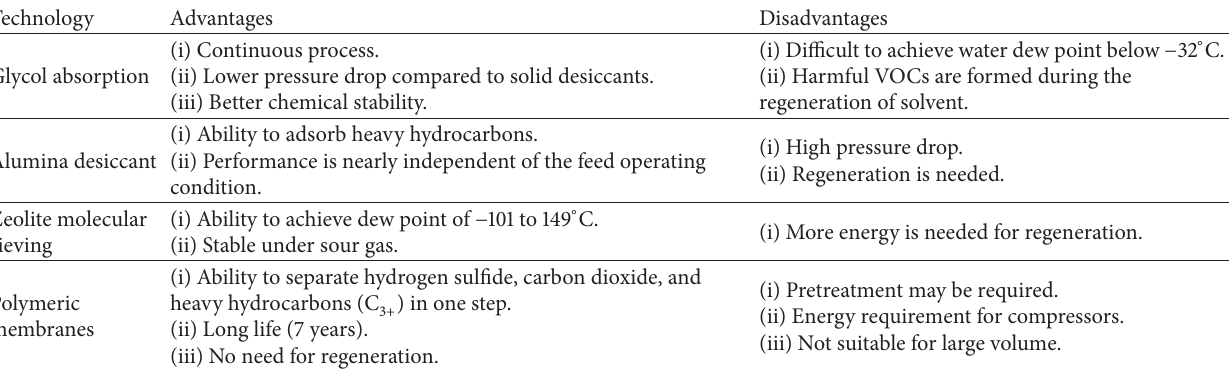
Table 10: Current technologies for dehydration of natural gas [141, 150].